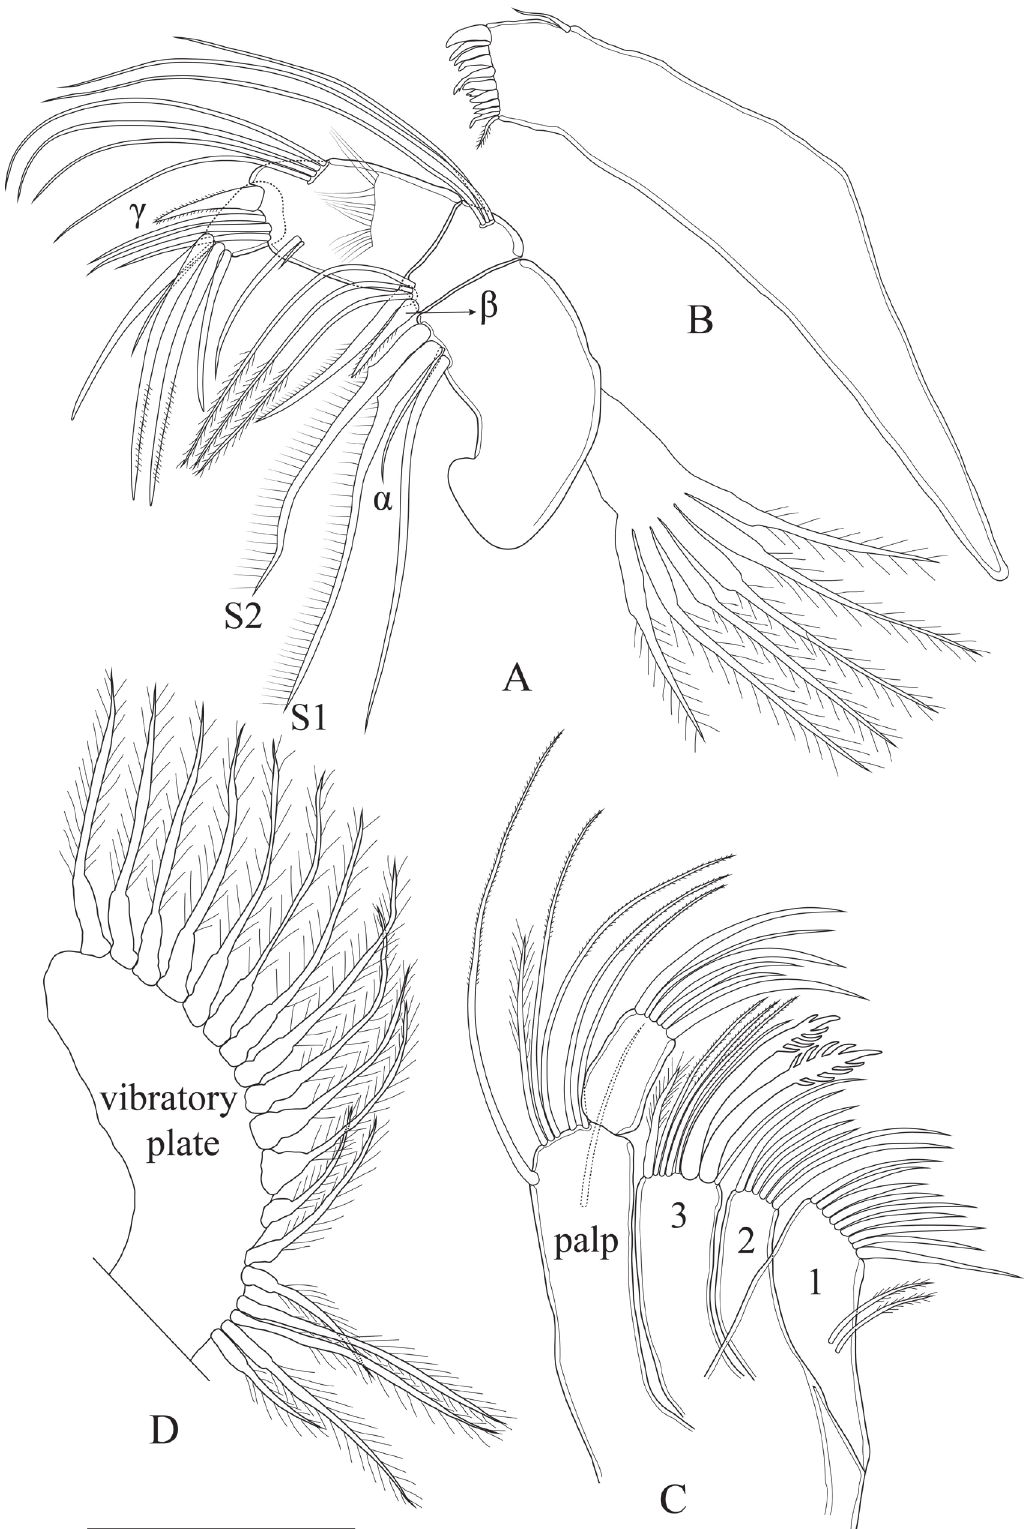
Fig. 5. Cyprinotus drubea sp. nov., ♀♀. A . Md-palp (MNHN-IU-2019-2541). B . Md-coxa (MNHN- IU-2019-2541). C . Palp and endites of Mx1 (chaetotaxy of endites not complete) (MNHN-IU-2019-2541). D . Vibratory plate of Mx1 (MNHN-IU-2019-2542). Scale bar: A = 101 µm; B, D = 139 µm; C = 84